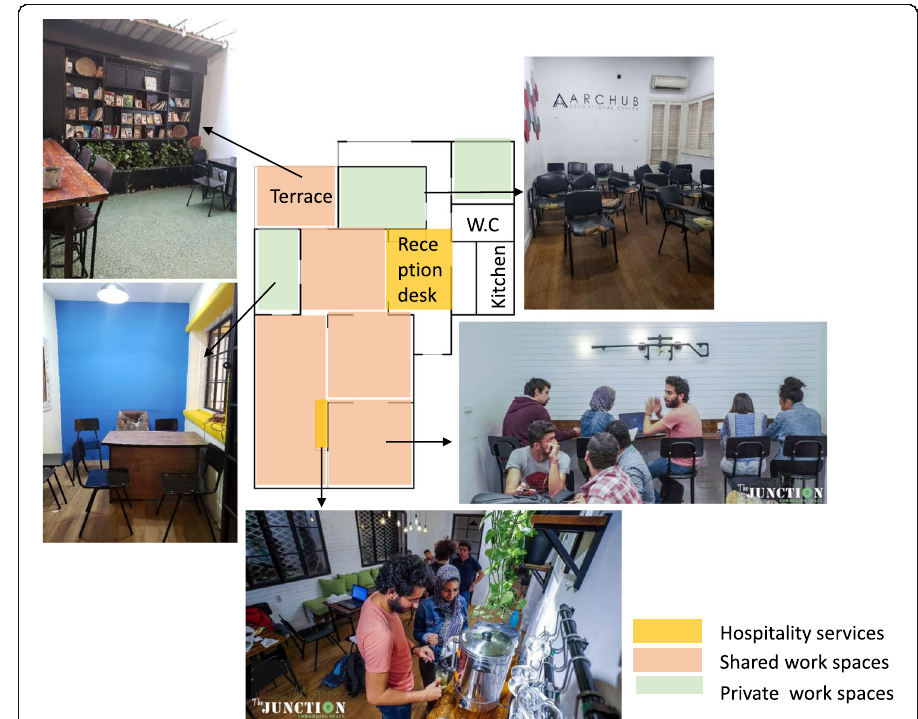
Fig. 7 A representation of co-working spaces; work environment fostering collaborative work: The Junction co-working space, elaboration by